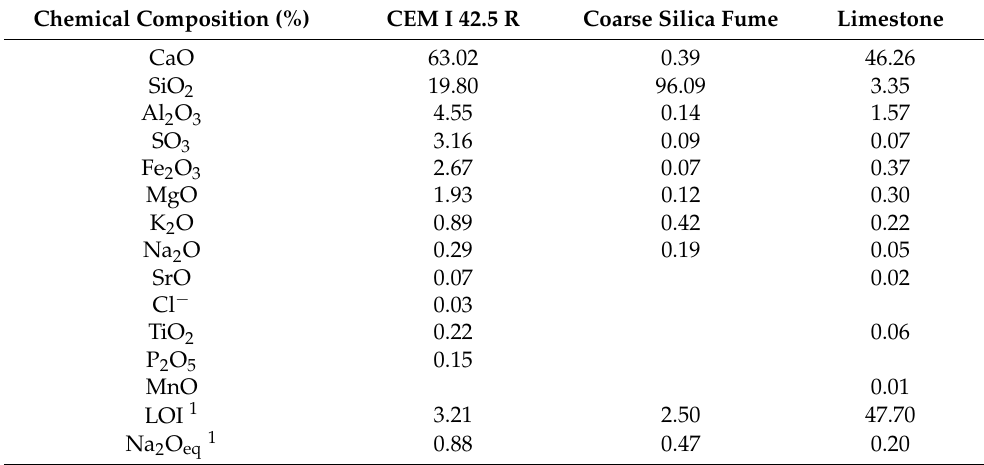
Table 1. Chemical composition of the CEM I 42.5 R, coarse silica fume, and limestone. Chemical Composition